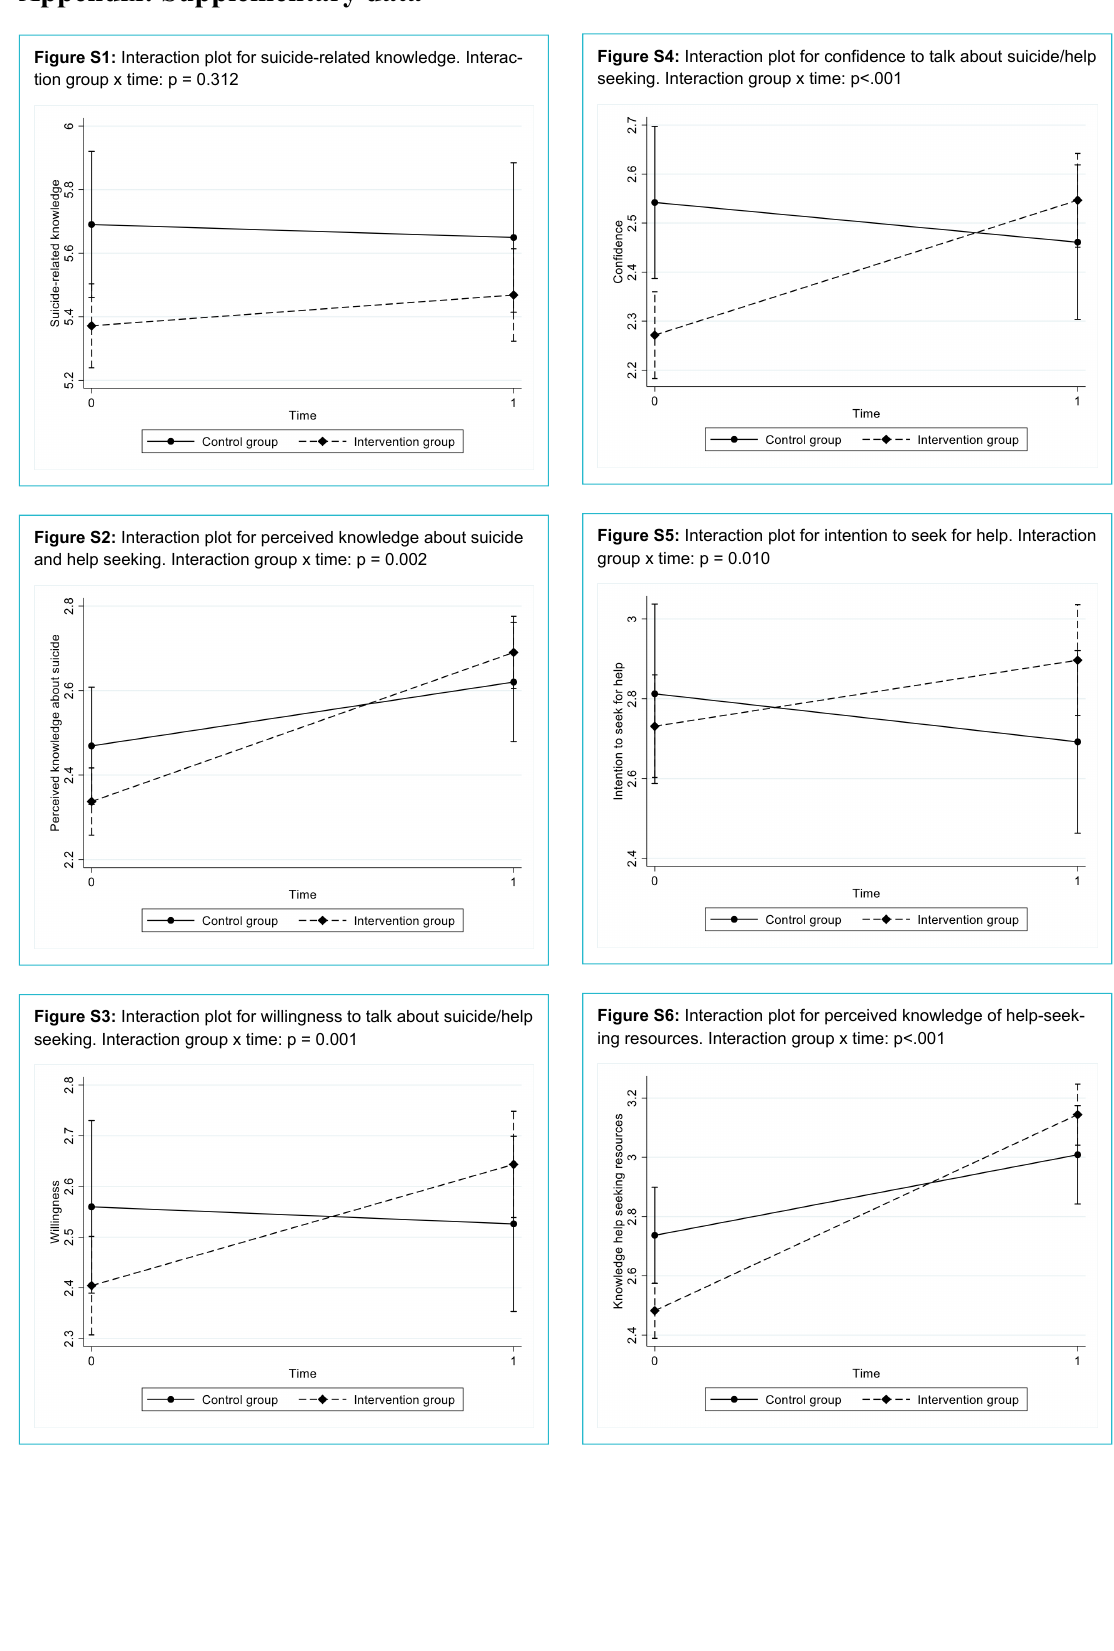
Figure S4: Interaction plot for confidence to talk about suicide/help seeking. Interaction group x time: p<.001